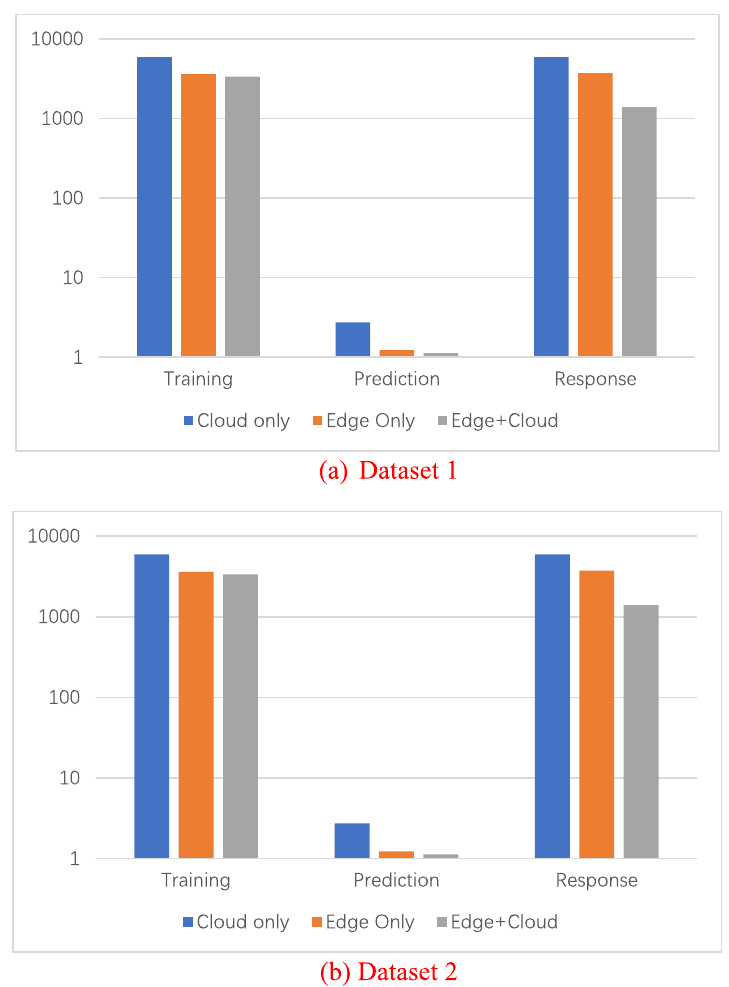
Fig. 16 Time complexity in terms of training, prediction and response time (measured in seconds) using two